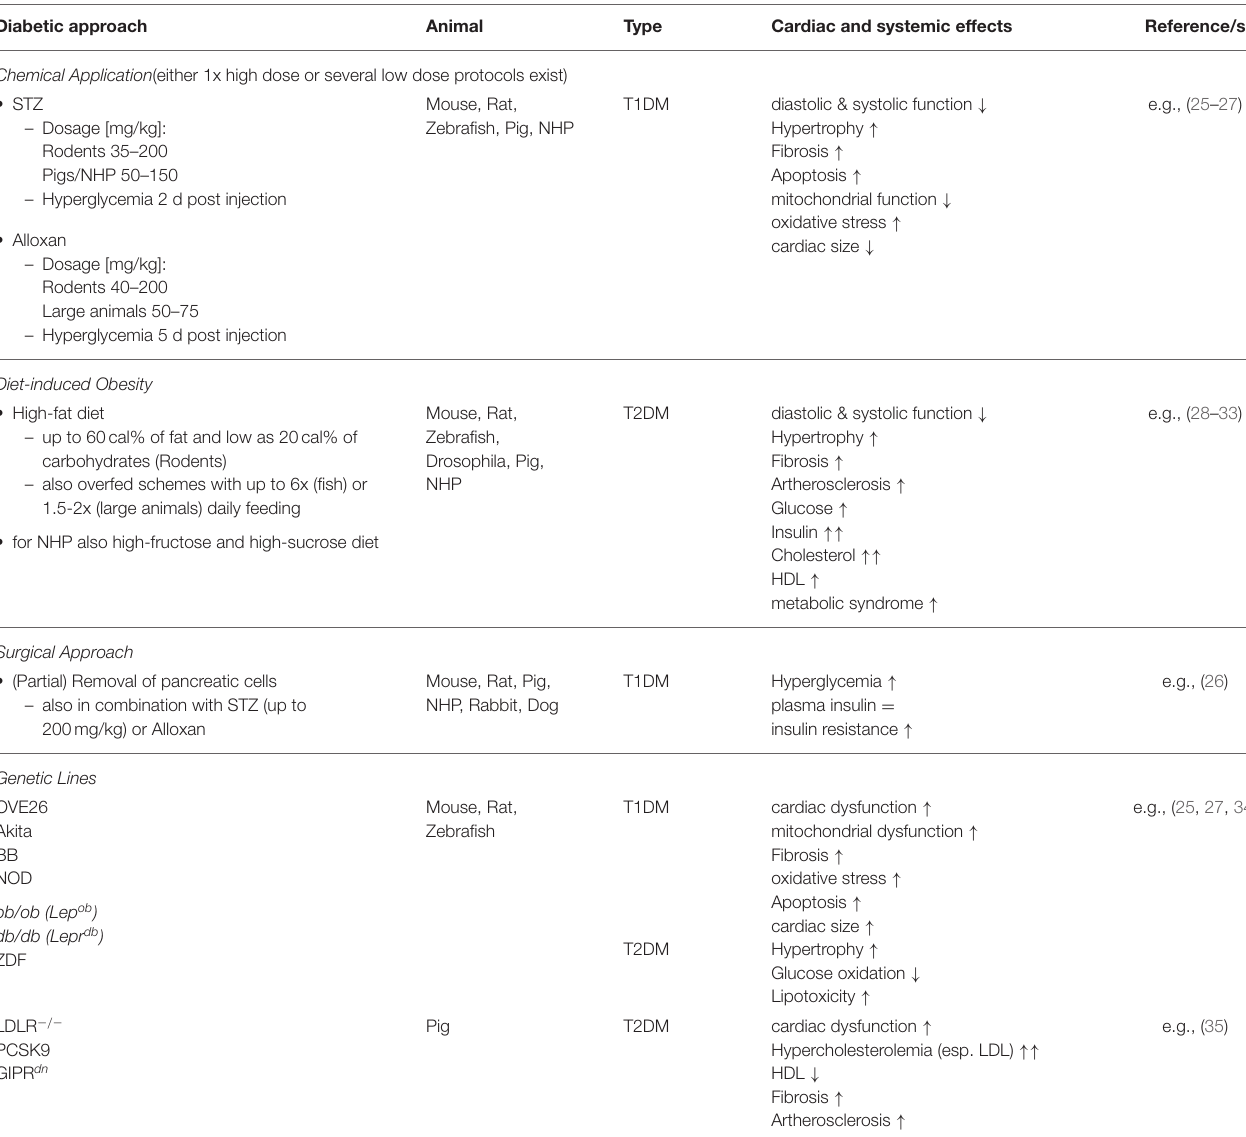
TABLE 1 | Brief overview of the commonly applied approaches for diabetes induction. Diabetic approach Animal Type Cardiac and systemic effects Reference/s Chemical Application (either 1x high dose or several low dose protocols